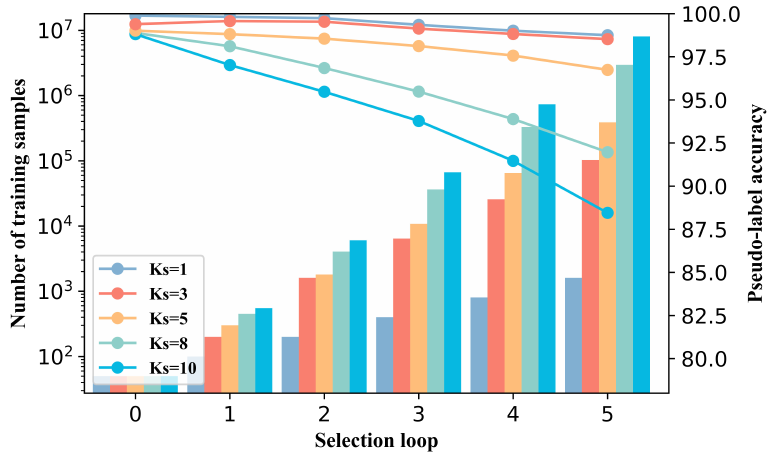
Figure 22. The number and the pseudo-label accuracy of the training set with different numbers of unlabeled samples connected to labeled samples (Ks) on Rs2-Sanf Data.